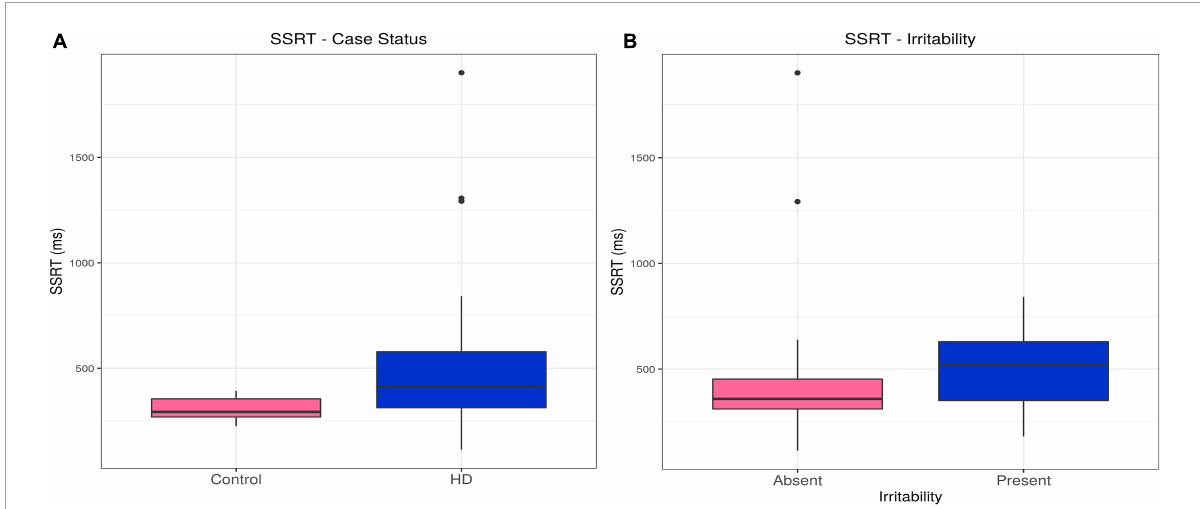
FIGURE2 SSRT–Effects of case status and irritability status. Box and whisker plots (median, interquartile range, and outliers as individual points). (A) Group differences between Huntington’s (HD) cases and control participants. (B) Group differences between irritable and non-irritable HD cases. SSRT, stop signal reaction